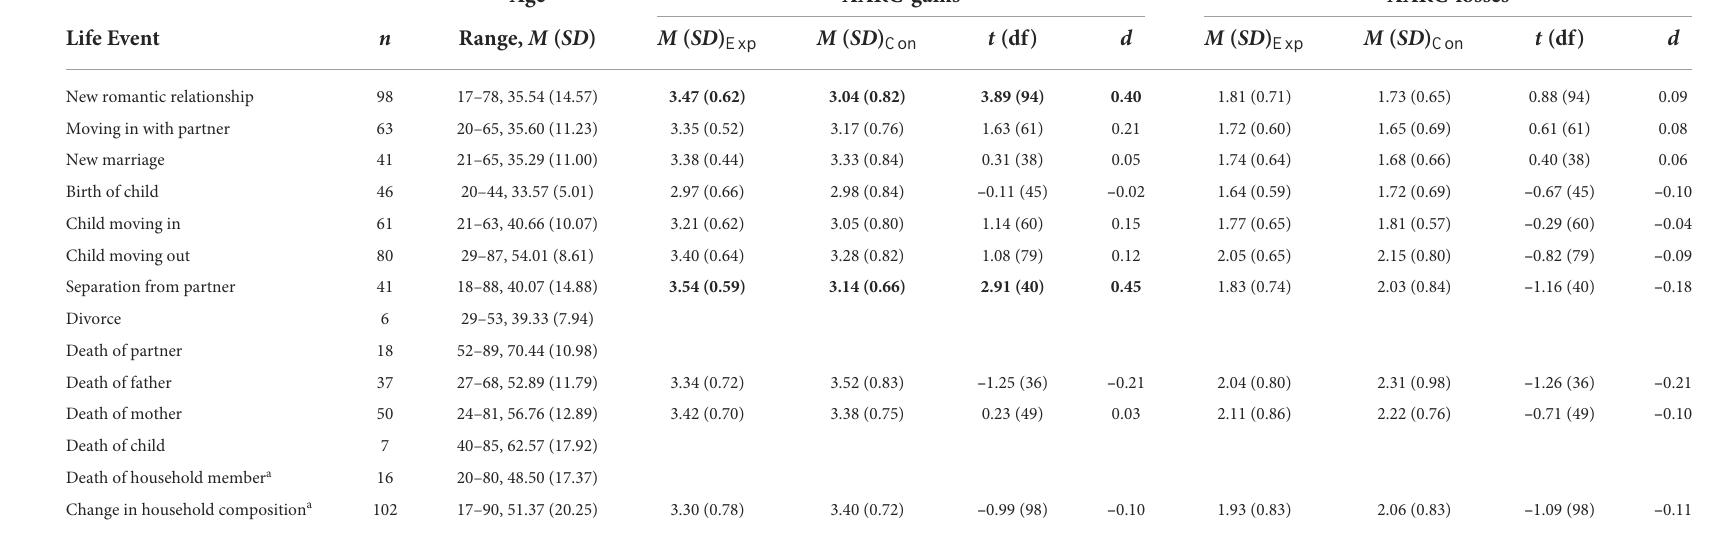
TABLE 2 Investigating the impact of specific life events in the family domain using propensity score